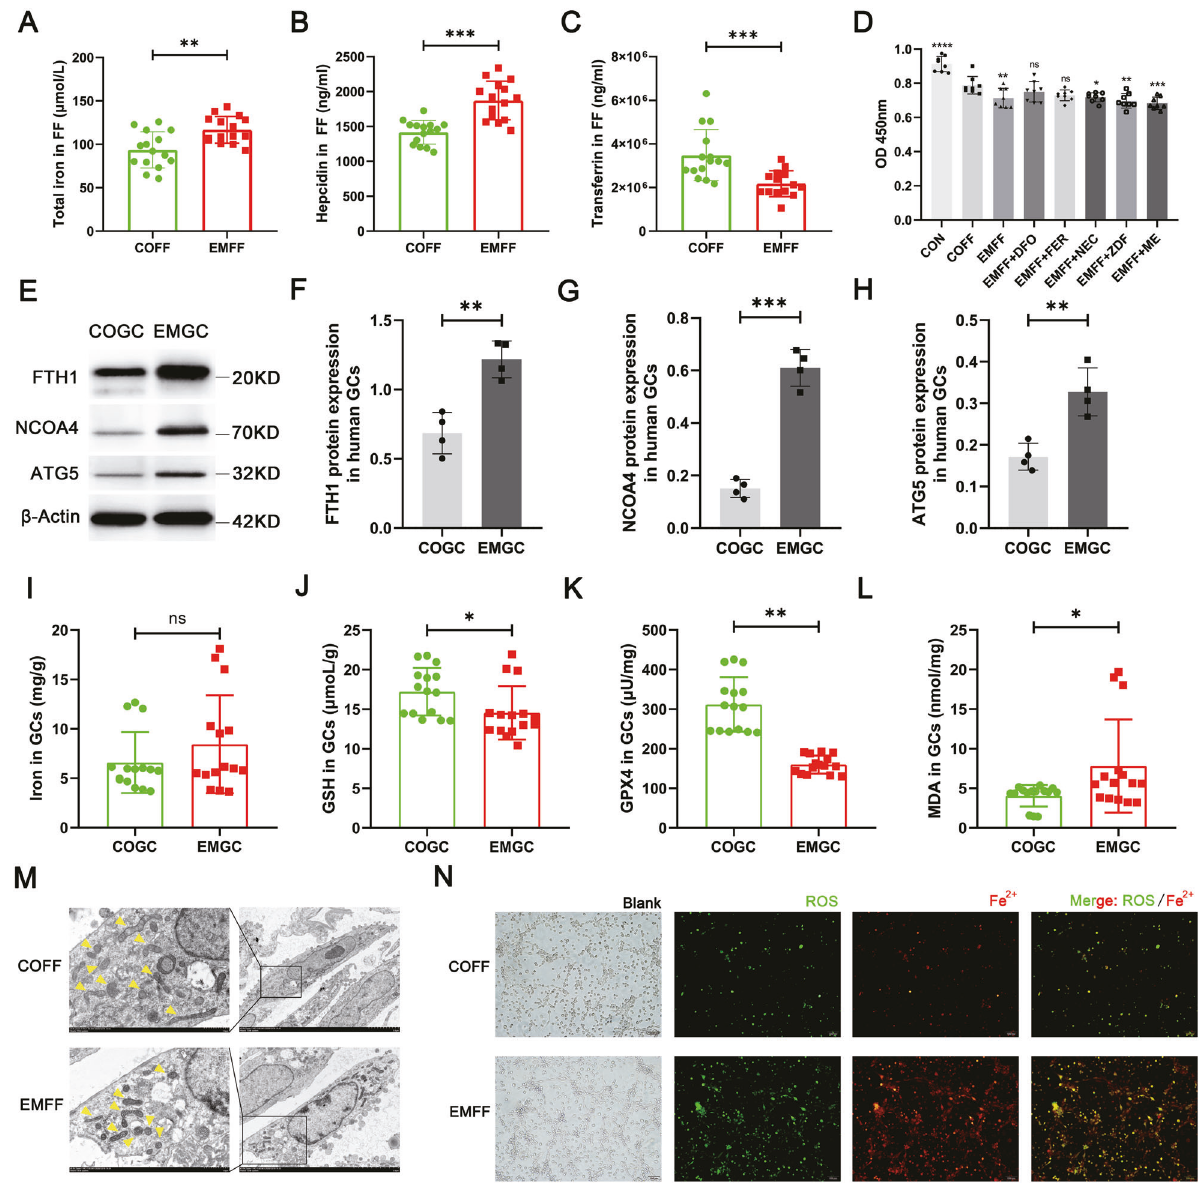
Fig. 2 Iron-overloaded EMFF induced ferritinophagy-dependent ferroptosis in granulosa cells. A – C Levels of total iron, hepcidin, and transferrin in EMFF ( n = 15) and COFF ( n = 15). Data are expressed as means±SD and analyzed by Student ’ s t test. D Results of mouse granulosa cells proliferation under different intervention conditions (each group in the fi gure is compared with COFF group). DFO, iron chelators; FER, ferroptosis inhibitor; NEC, necrosis inhibitor; ZDF, apoptosis inhibitor; ME, autophagy inhibitor. Data are expressed as means ± SD and analyzed by one-way ANOVA. E – H Comparison of ferritinophagy-related proteins FTH1, NCOA4, and ATG5 between human granulosa cells of infertile patients with EMs (EMGC) and of control group (COGC). The expression of β -actin was used as an internal control. Data are expressed as means ± SD and analyzed by Student ’ s t test. I – L Detection of ferroptosis-related indicators iron, GSH, GPX4, and MDA in COGC and EMGC. Data are expressed as means ± SD and analyzed by Student ’ s t test. M Representative images of the mitochondrial morphology of mouse granulosa cells intervened by COFF and EMFF were observed under TEM. Yellow arrows indicate mitochondrion. Scale bar = 1.0 µm. Scale bar = 5.0 µm. N Representative images of ROS and ferrous ion fl uorescence staining after COFF and EMFF intervention in mouse granulosa cells. Scale bar = 100 µm. * P < 0.05, ** P < 0.01, *** P < 0.001, **** P < 0.0001, and ns, no signi fi cance. granulosa cells in iron overload may affect oocyte function by from exosomes of granulosa cell in iron overload and under releasing exosomes containing abnormal miRNAs. We further normal conditions, Fig. S3 shows the differential miRNA expression performed intersection analysis of differential miRNAs (differential between the FAC and CON groups, a differential miRNA fold > 1.5) between the CON and FAC, DFO and, and VE and FAC expression heatmap, and KEGG enrichment analysis of the groups and found 14 differential miRNAs contained by all three differential miRNAs (differential fold > 1.5). A total of 65 differential comparison groups (Fig. 4D). A clustered heatmap analysis of the miRNAs were discovered and predicted by target genes, which hit expression of these 14 differential miRNAs among the four groups several signaling pathways, including calcium, MAPK, cell cycle, revealed that the iron overload group (FAC) was distinct from the oocyte meiosis, and ferroptosis signaling pathway. Therefore, Cell Death and Disease (2022)